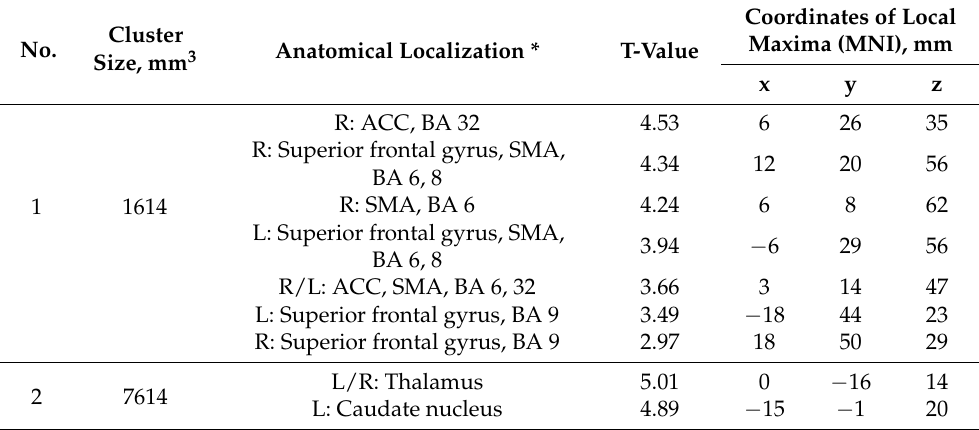
Table 2. Decreased BOLD-signal in equiprobable Go and NoGo trials (“Go + NoGo” contrast) in the OCD group compared to the HC group. Cluster-level FWE-corrected threshold of 0.05. Cluster No. Size, mm 3